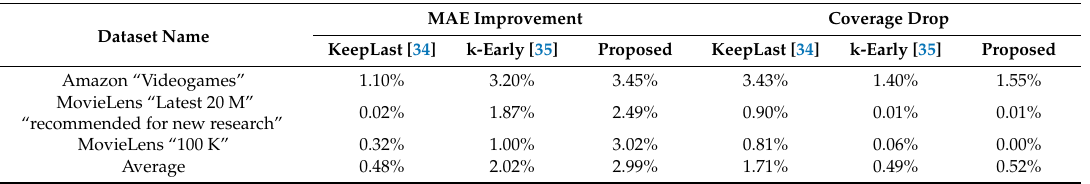
Table 9. RAI variants